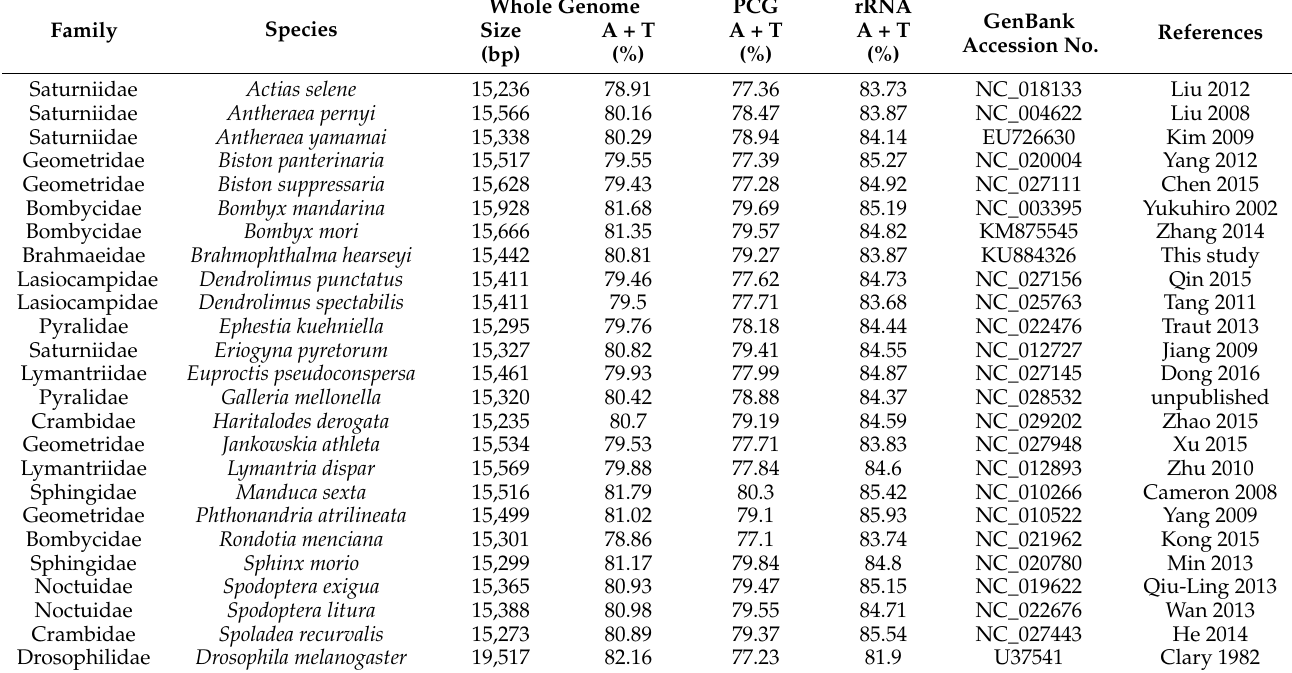
Table 1. The available insect mitogenomes (1 new and 24 obtained from GenBank) and their characteristics. Family